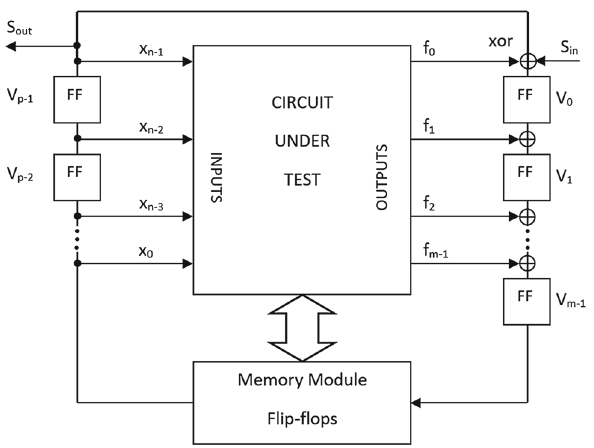
Fig. 36 Memory module under test